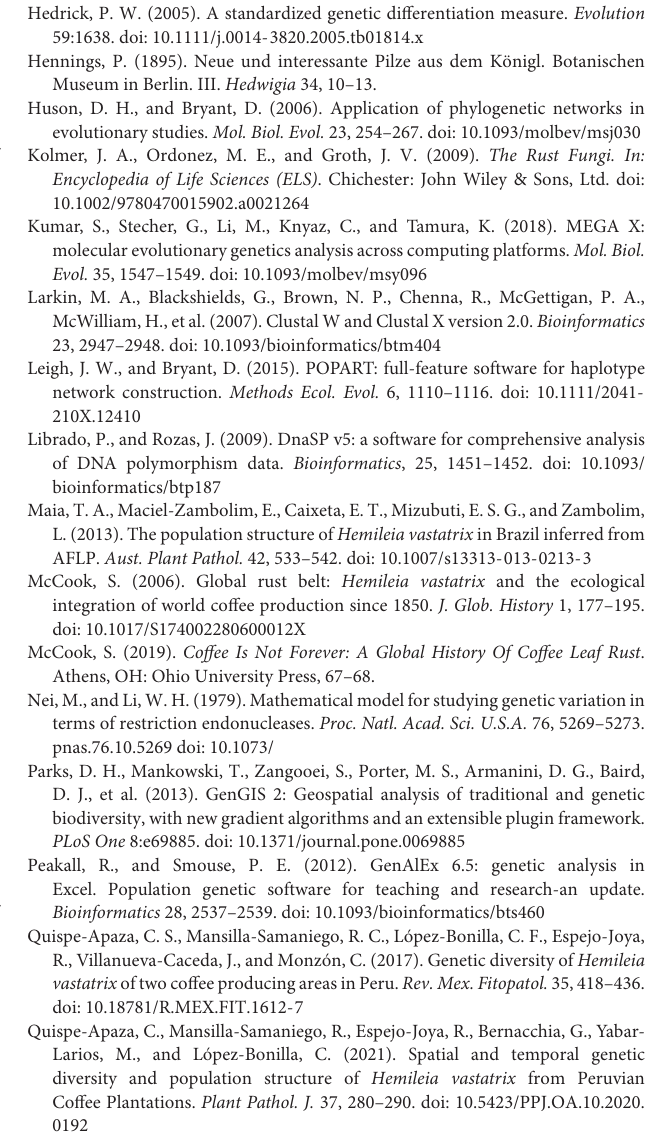
Supplementary Table S1 | Internal transcribed spacer (ITS) sequences for coffee leaf rust fungus dowloaded from Genbank NCBI. Supplementary Table S2 | Coffee leaf rust samples collected in Vietnam and Thailand. Supplementary Table S3 | Information including query cover, % identity, name, and accession of the query sequences after using the NCBI BLAST tool for Vietnamese and Thailand coffee leaf rust fungus sequences. Supplementary Table S5 | Number of haplotypes, haplotype diversity, and nucleotide diversity of the Hemileia vastatrix populations. Supplementary Table S6 | Tajima’s D value for the Hemileia vastatrix populations. Supplementary Table S7 | Genetic differentiation (measured by φ PT) of the Hemileia vastatrix populations between Vietnam and other countries. Supplementary Material S4 | Alignment dataset used for the population genetic